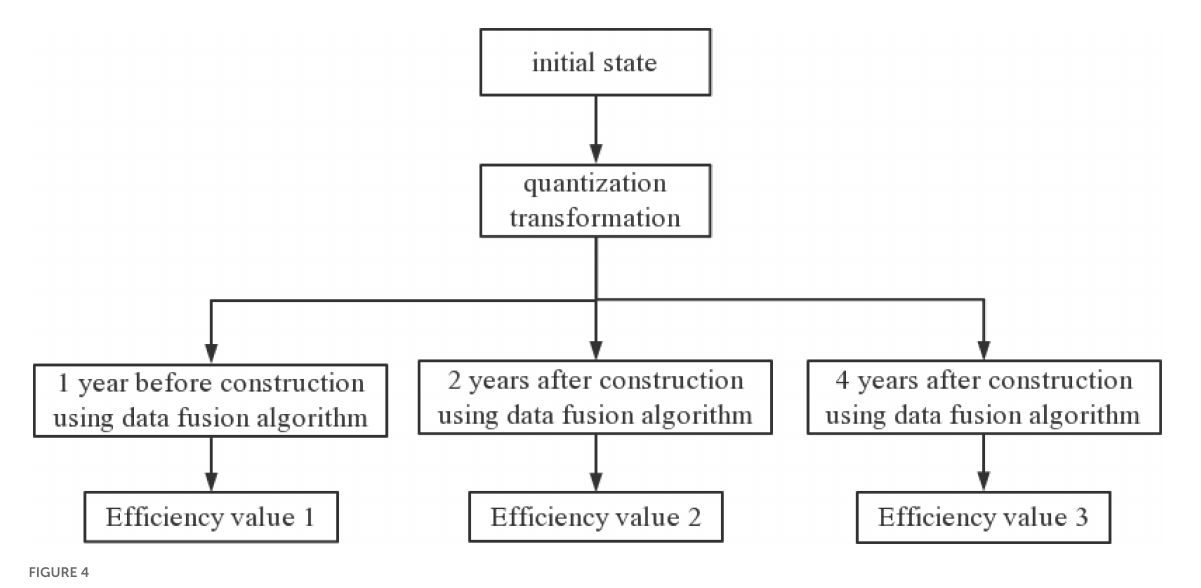
FIGURE4 Flow chart of model algorithm based on data fusion algorithm